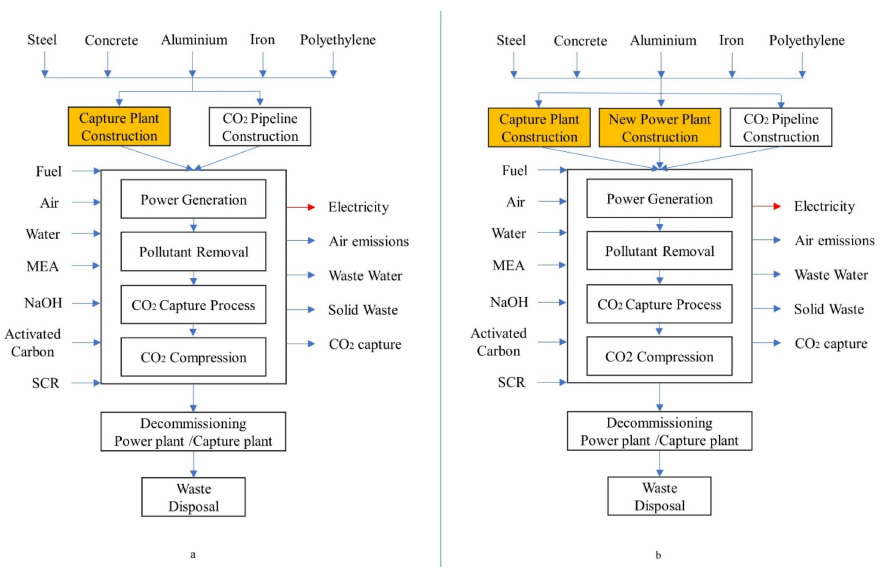
Figure 5. ( a ) Life cycle boundaries for attaching existing NGCC power plants with CO 2 Capture Plant ( b ) Life cycle boundaries for construction of new NGCC power plants with CO 2 Capture